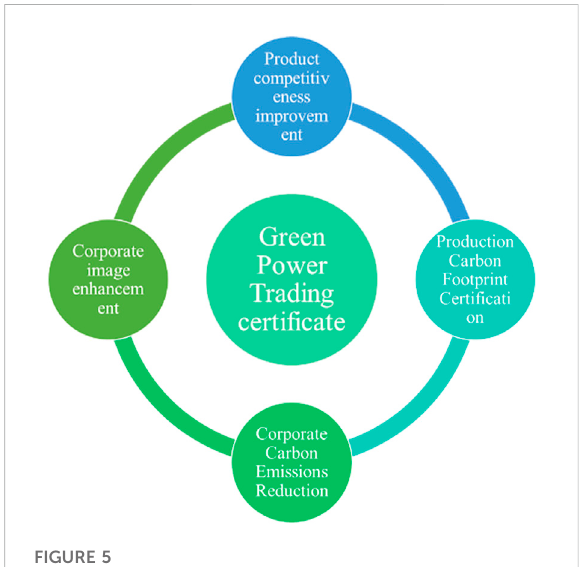
FIGURE 5 Applications of green electricity trading certi fi